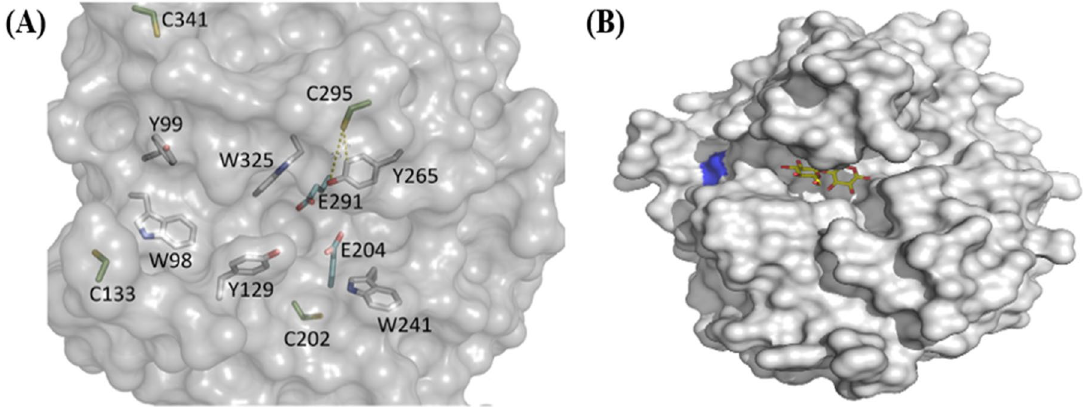
Figure 1. The 3-dimensional (D) modelling of the GH5-p4818Cel5_2A processive cellulase as generated by the SWISS-MODEL online server using the crystal structure of a homologous cellulase (PDB ID:1E5J) as a template. The 3-D structure of the GH5-tCel5A1 was based on PDB#: 3AOF. The 3-D structure images were generated using PYMOL (www. pymol. org). (A) The GH5-p4818Cel5_2A 3-D model shows four predicted cysteine (Cys) residues. C295 is likely linked to the enzyme inactivation due to auto-oxidation conditions such as when exposed to airborne O 2 and solubilized O 2 in aqueous buffers; and (B) The 3-D structure of GH5- tCel5A1 shows only one Cys residue (blue) located near the substrate binding cleft. Cellobiose as a typical end- product of this enzyme-catalyzed reaction is shown in yellow colour.